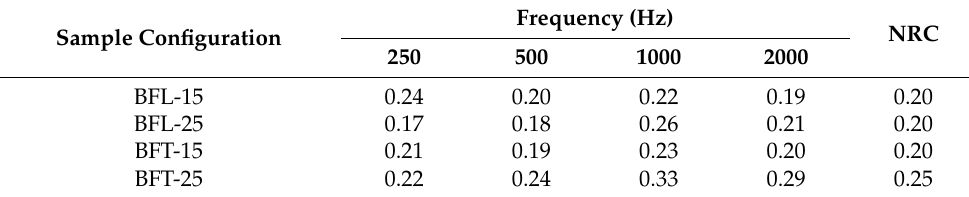
Table 7. NRC of Buriti foam